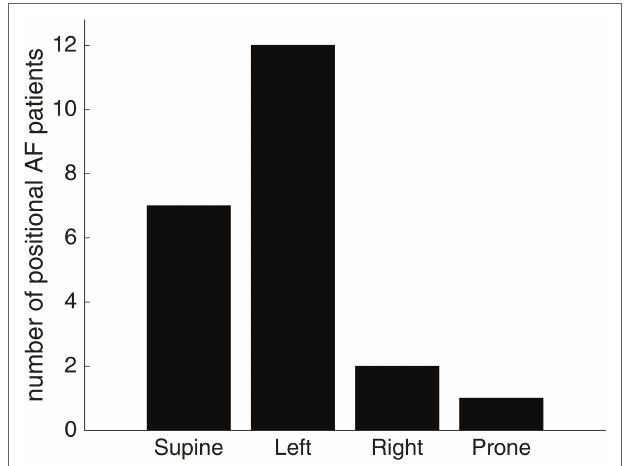
FIGURE 2 | The self-reported AF-triggering body position in patients with positional AF. Twenty-one patients reported that taking a specific body position triggered their AF symptoms. The most AF-triggering body position was the left lateral and supine position. A χ 2 goodness of fit test demonstrated a statistically significant difference in the prevalence of AF-triggering body positions ( p = 0.003). One patient described both the left and right lateral body position as symptom